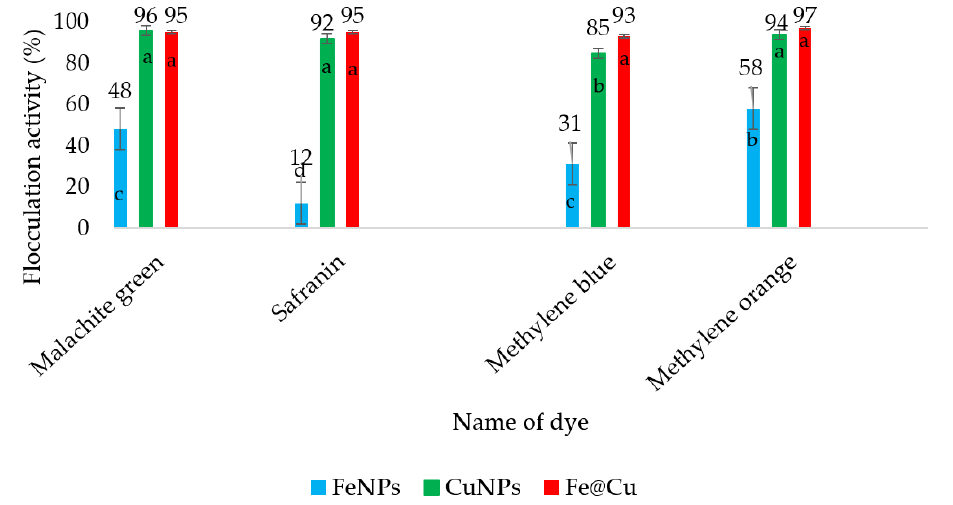
Figure 4. Application of nanoparticles on the removal of dyes at room temperature di ff erent letters (a, b, c and d) are significantly di ff erent at ( p < 0.05).